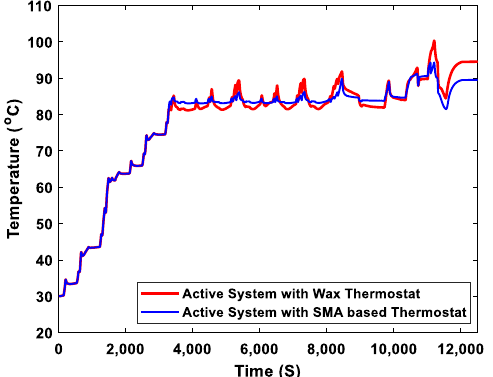
Figure 12. Simulated coolant temperature of the active engine cooling system with a wax thermostat and the active engine cooling system with an SMA-based thermostat.